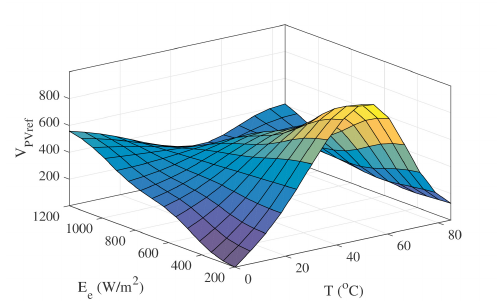
Figure 6. 3–D plane for v pvref vs. E e (W/m 2 ) and T( o